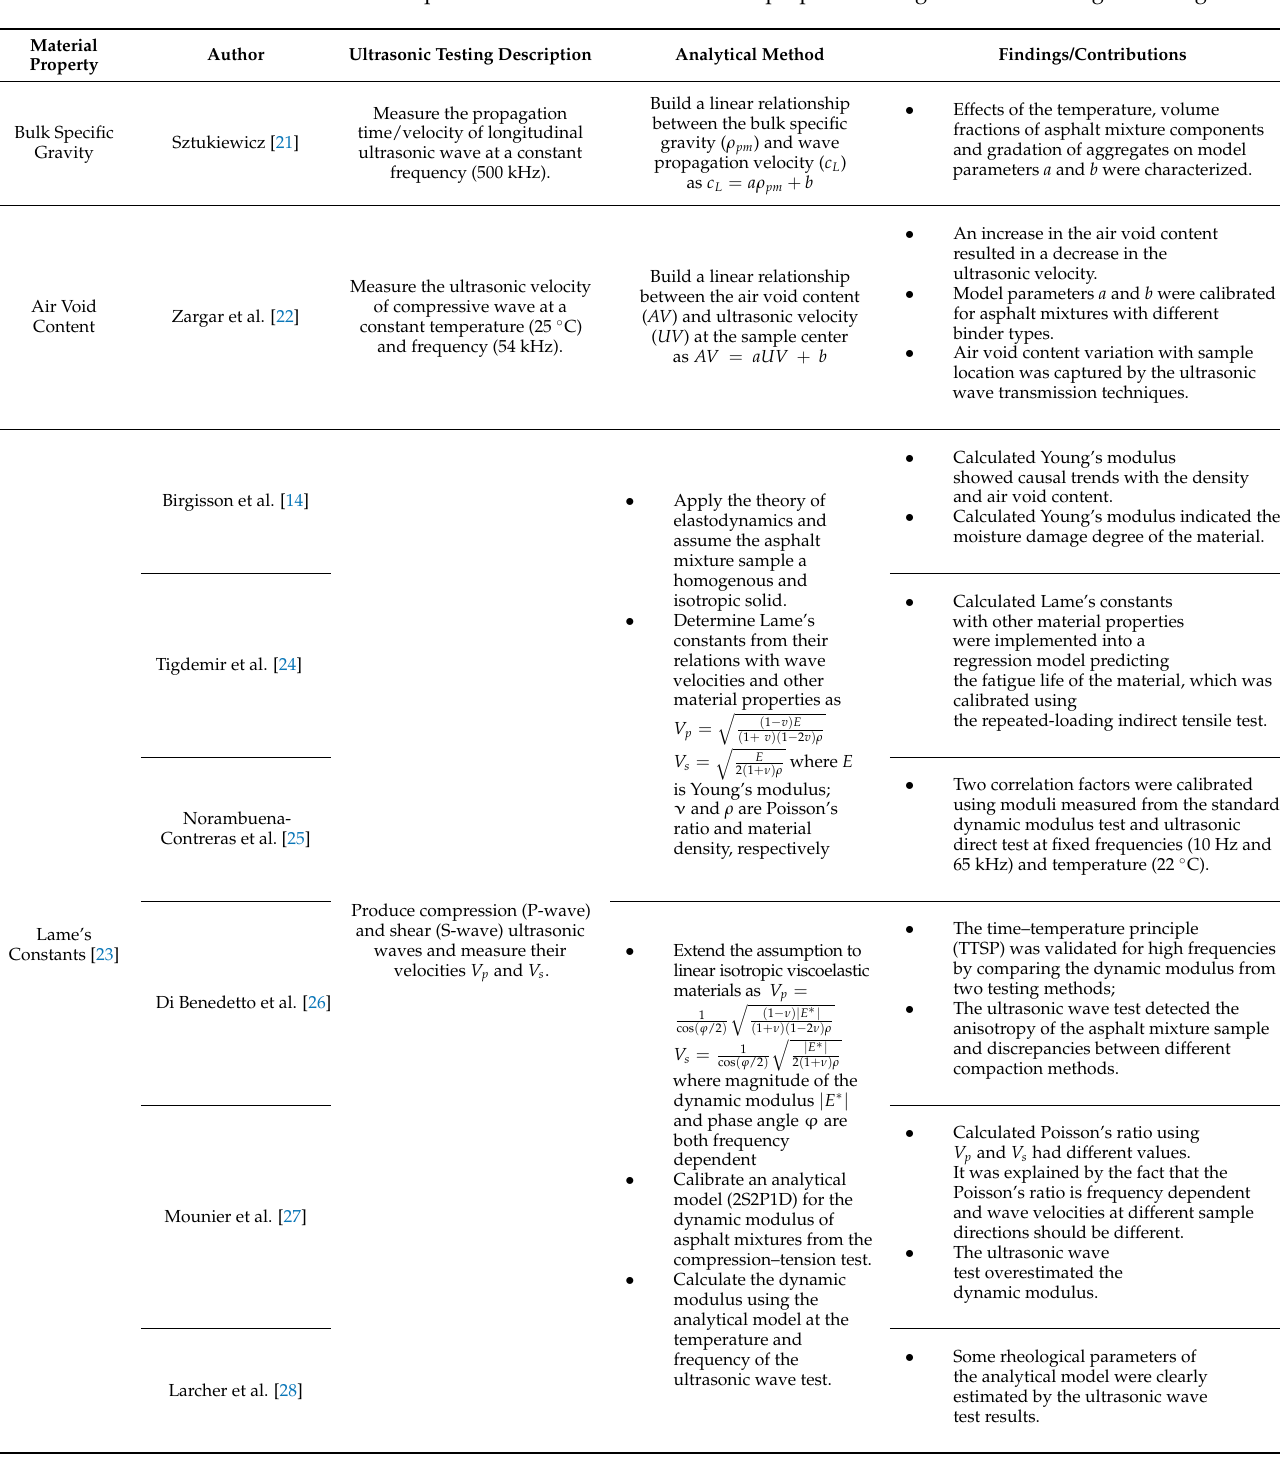
Table 1. Representative methods for material properties using ultrasonic testing